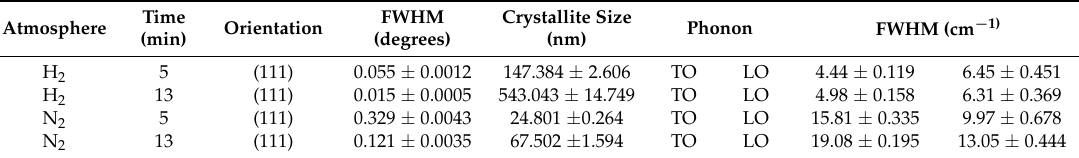
Table 3. It summarizes the FWHM sample of peak (111) from XRD and the peaks from Raman spectra. These values were determined by fitting a Gaussian function. The crystallite size was obtained by Scherrer’s equation.